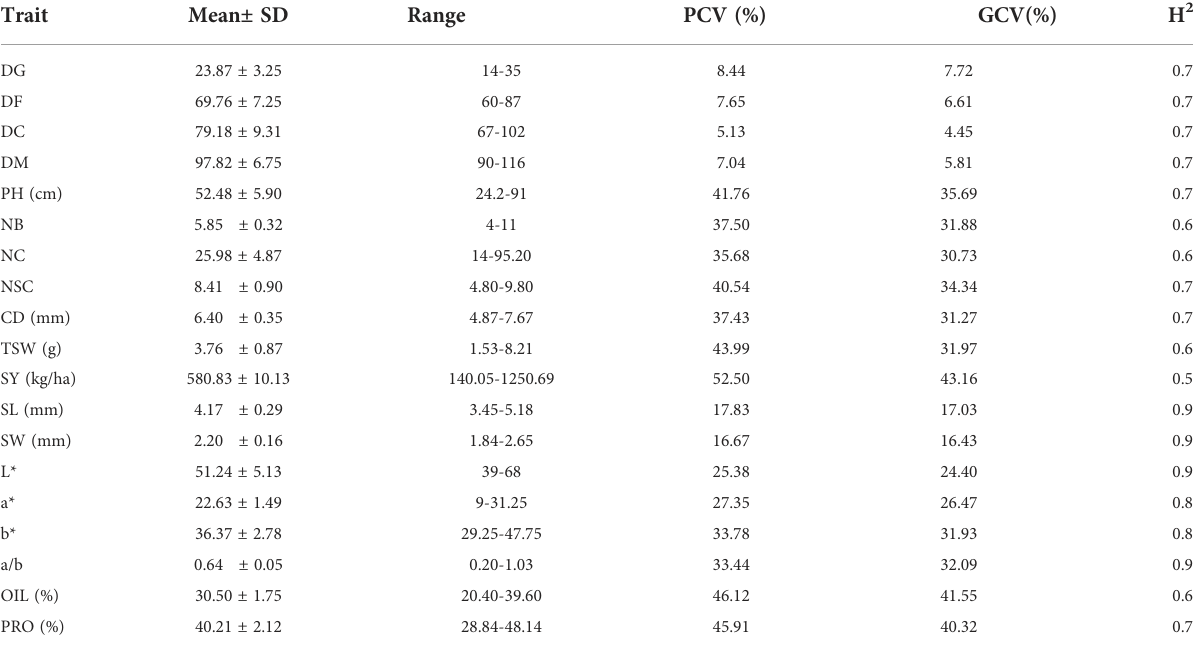
TABLE 3 Estimates of genetic parameters and phenotypic performance of 19 traits evaluated in 144 fl ax genotypes during two years.